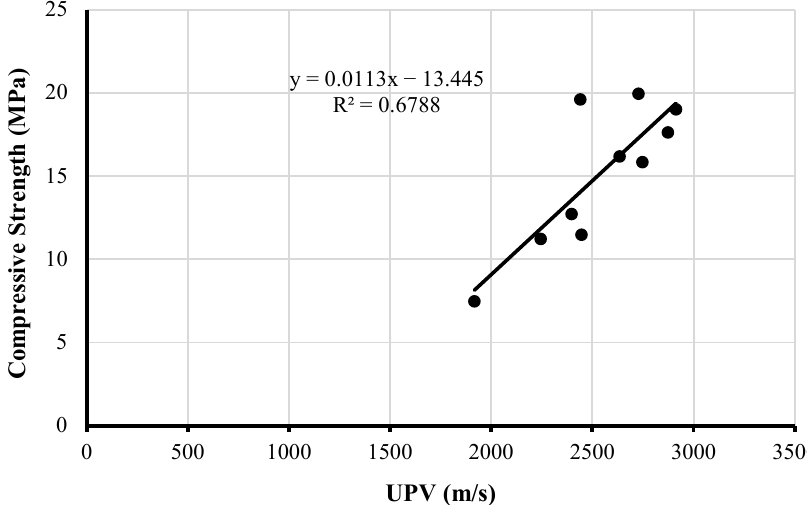
Figure 10. UPV vs. compressive strength of 35-year-old bricks.